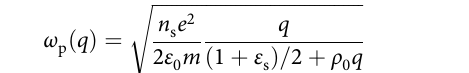
Fig. 1c. When the polarization of incident light is along the ribbon direction, the extinction spectrum is dominated by free carrier response (Drude scattering rate 2000 cm − 1 ), as shown in Fig.